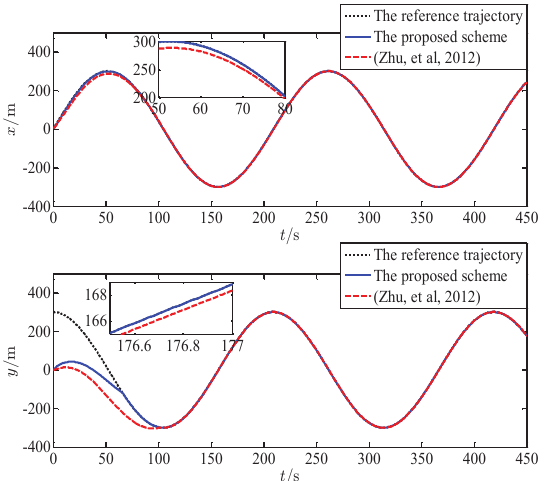
Figure 3. Tracking performance results of circular trajectory.